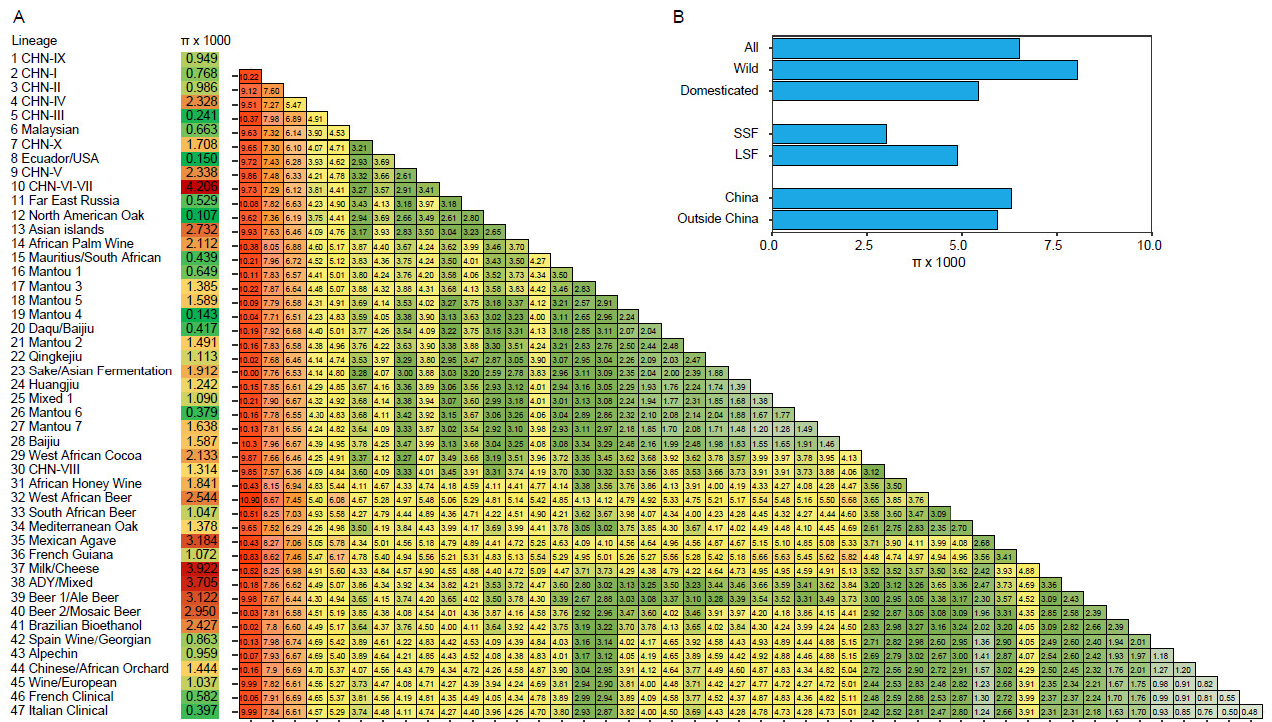
Figure 5. Sequence diversity within and divergence between different lineages ( A ), and sequence diversity of different groups ( B ), of S. cerevisiae . The data were calculated from the genome-wide SNPs from a set of 612 strains compared in Han et al. [22] representing the maximum global genetic diversity and almost all recognized lineages of S. cerevisiae . SSF, solid-state fermentation; LSF, liquid-state fermentation.